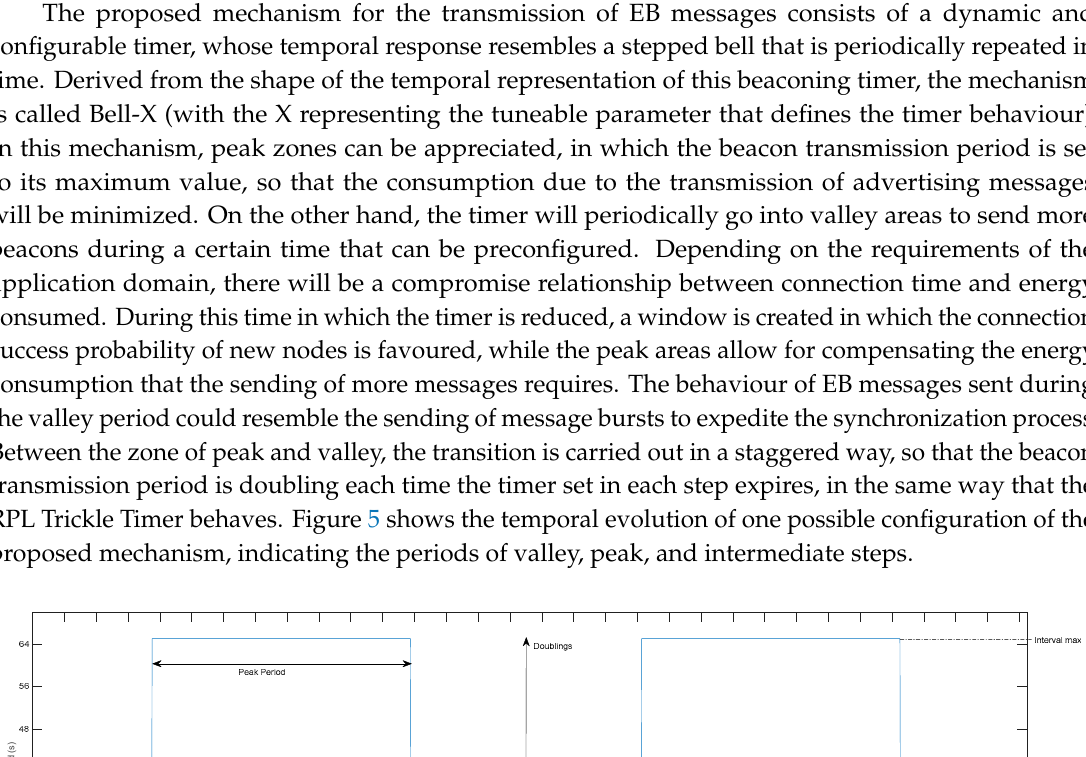
Table 2. Configuration parameters for the proposed dynamic method.